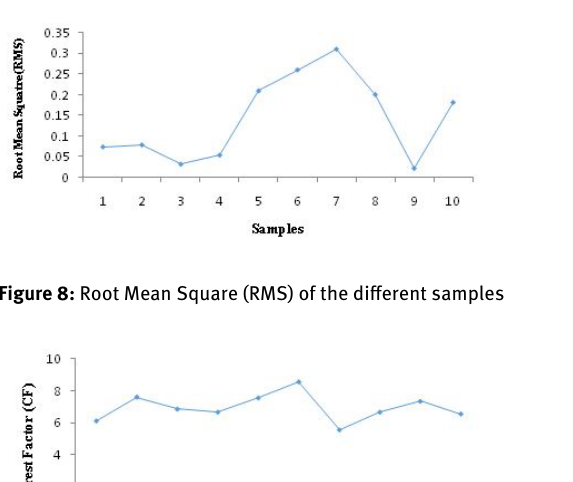
Figure 7: Standard Deviation (SD) of the different samples